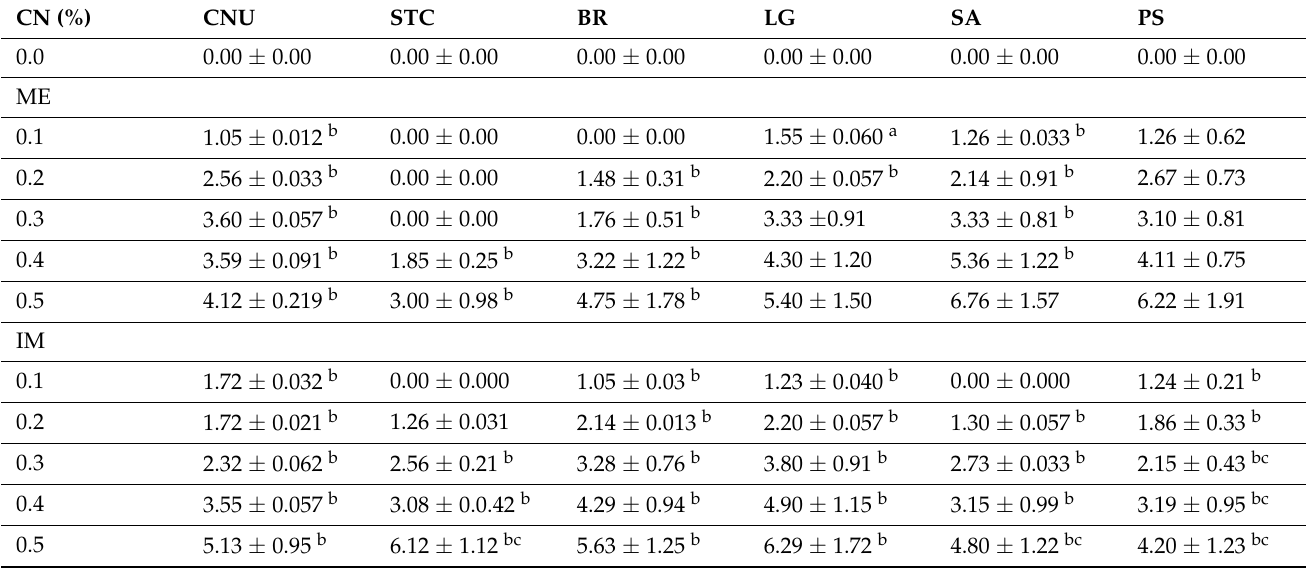
Table 6. Percentage of meiotic abnormality in metaphases I and II and anaphases I and II of plates of P. sativum in PMCS exposed to different concentrations of ME and IM for 6 h.